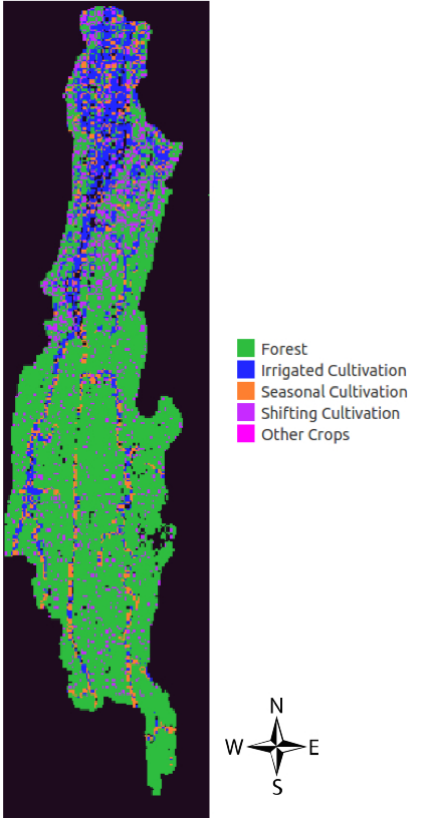
Figure 6. Land use map for 2035 when simulated with Incentivisation of settled forms of agriculture scenario for the